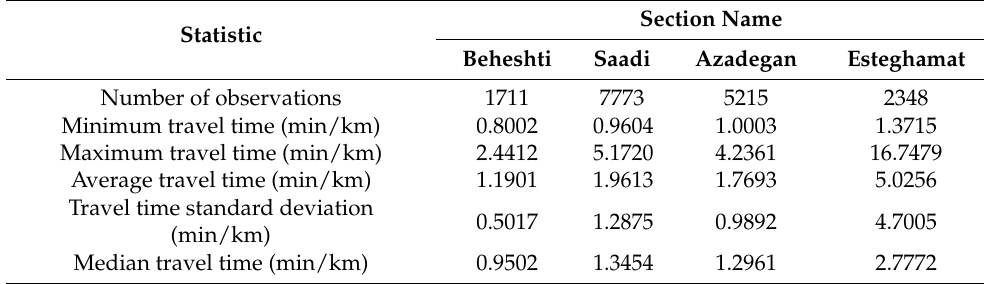
Table 4. Statistical information for the collected travel time data.